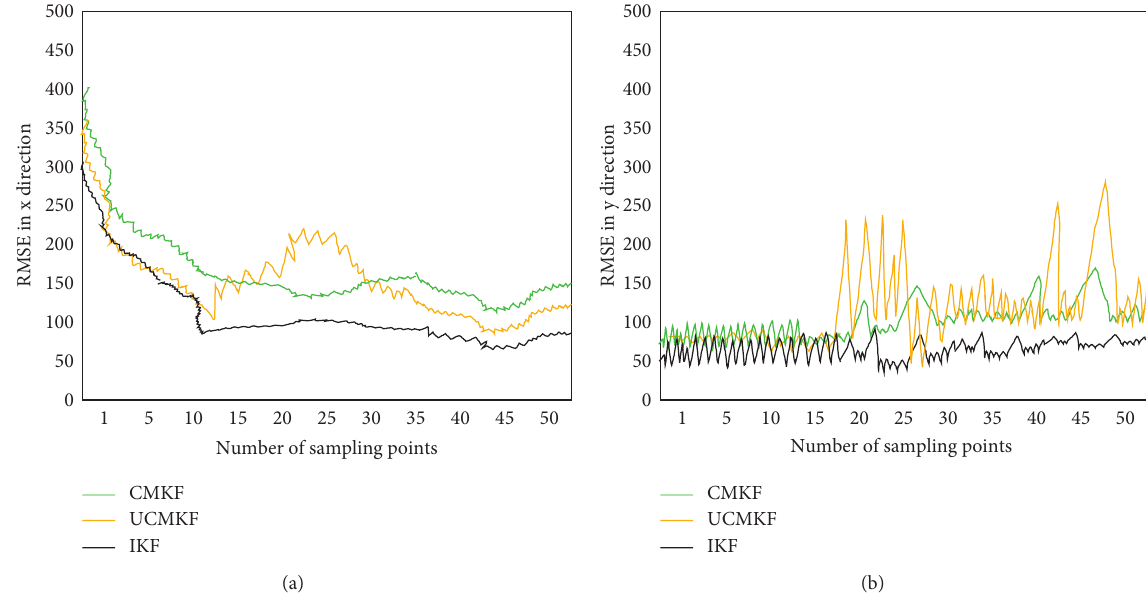
Figure 4: Comparison of root mean square error of position in X and Y direction. (a) Root mean square error of position in x direction. (b) Root mean square error of position in y direction.